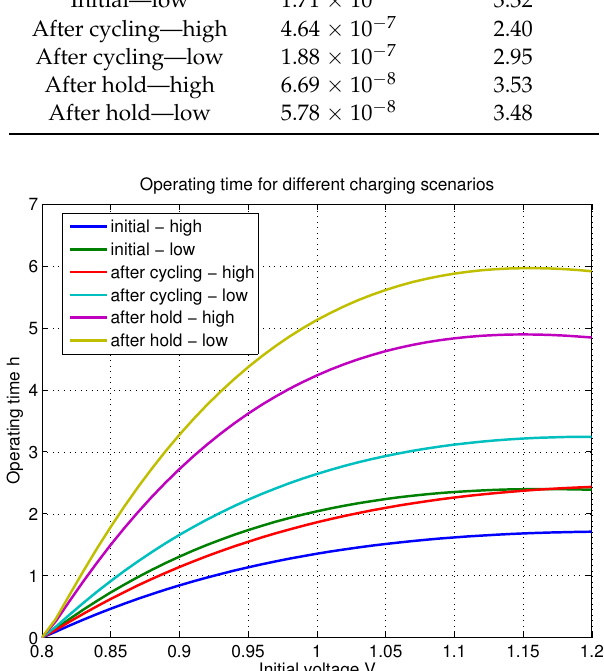
Figure 3. An example illustration of operational times when using different charging scenarios with respect to initial charging voltage